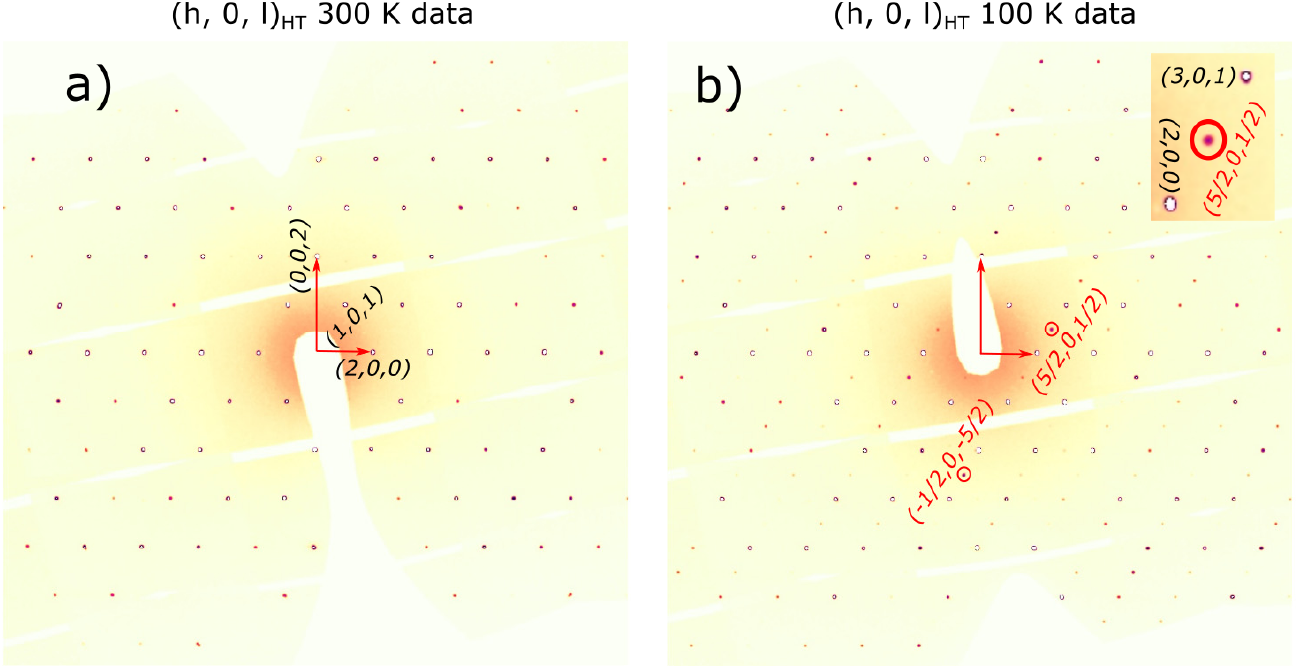
Figure 4. Reconstructed (h 0 l) reciprocal space section at 300 K in panel ( a ) and 100 K in panel ( b ) from the data collected at beamline P24. Several superlattice reflections are marked by red circles; the inset shows the zoom in for one of the superlattice reflections.